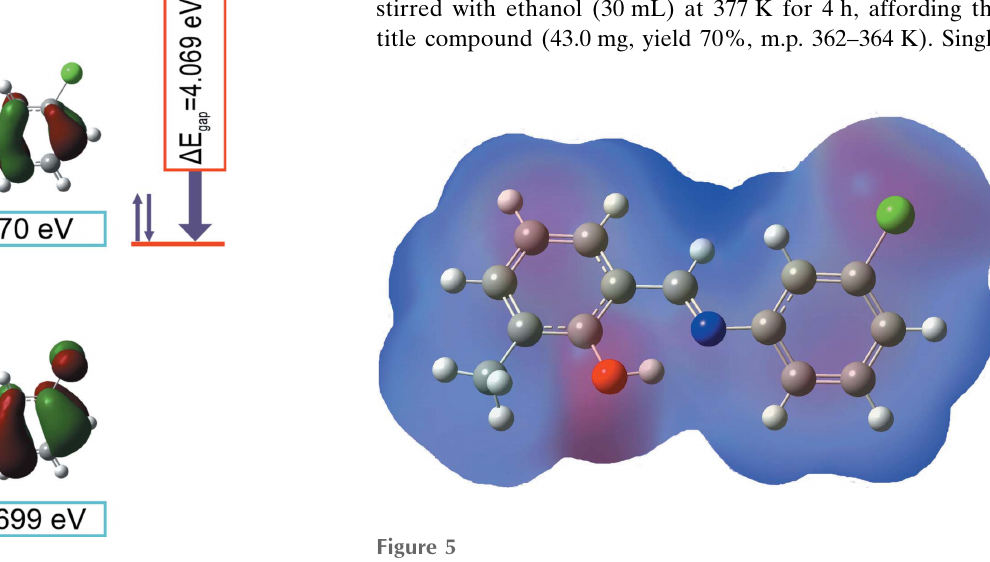
Figure 4 Plots of the frontier orbitals and the energy gap for